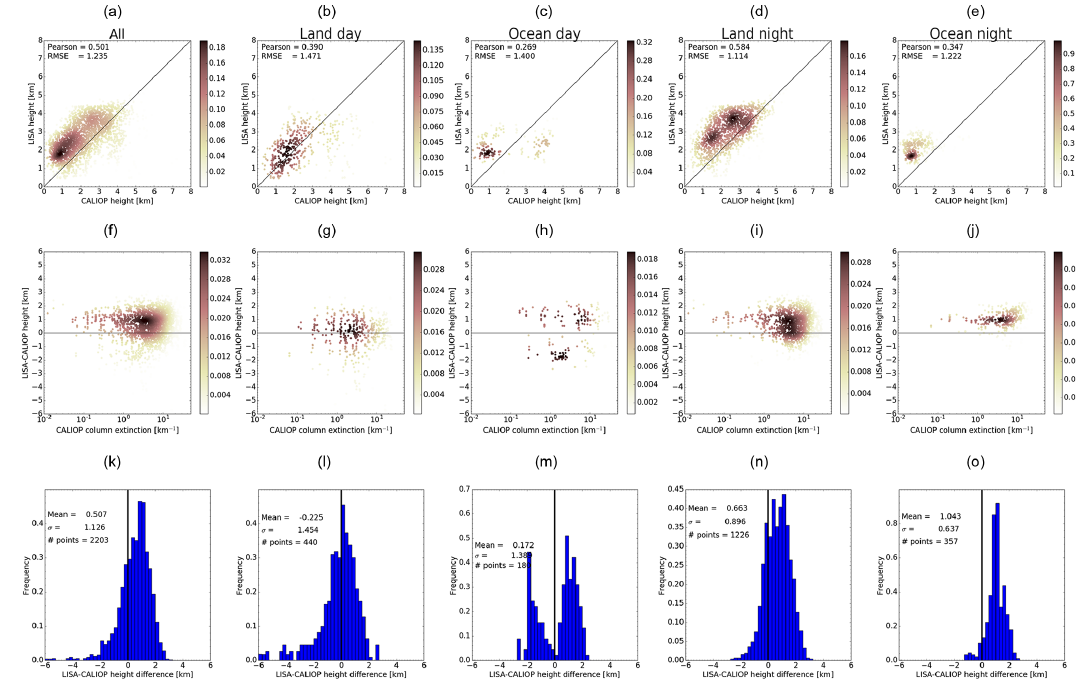
Figure A8. Similar to Fig. A5 but for the LISA